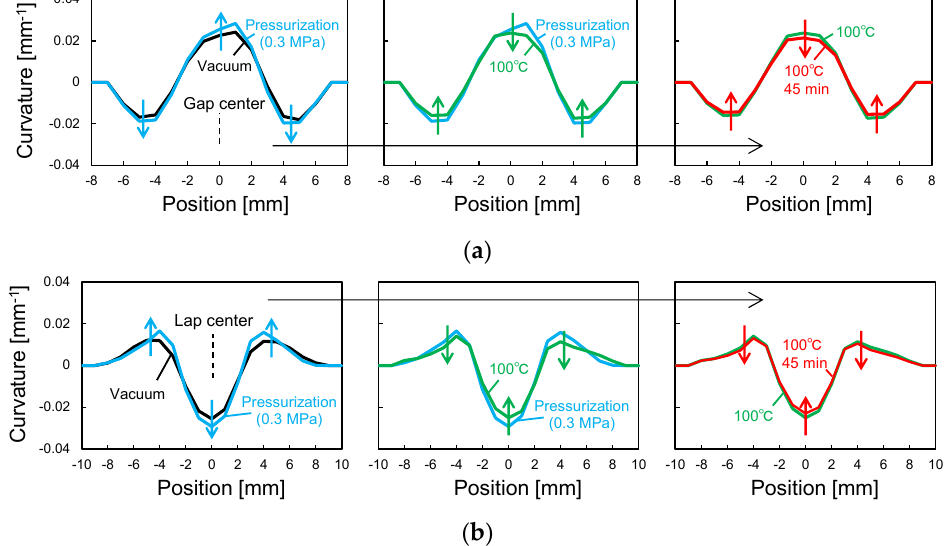
Figure 14. Curvature change of 90-sensor during consolidation. ( a ) Gap. ( b ) Lap.